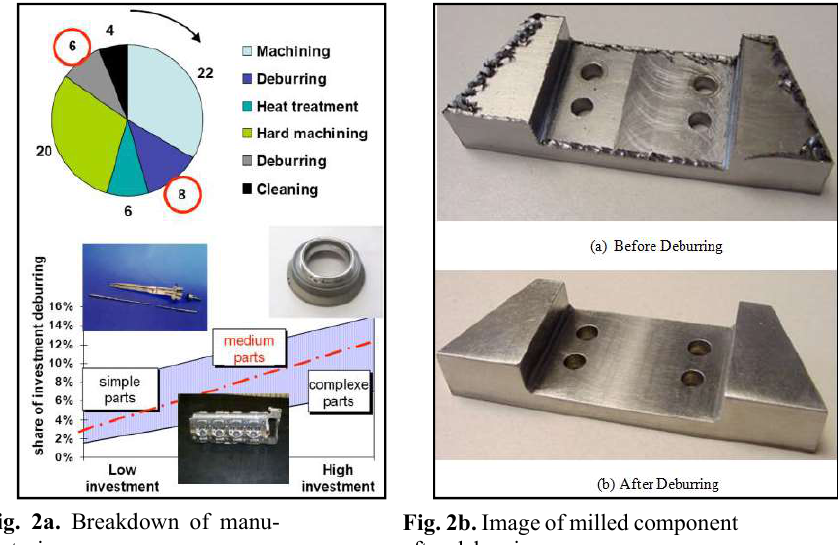
Fig. 2b. Image of milled component after